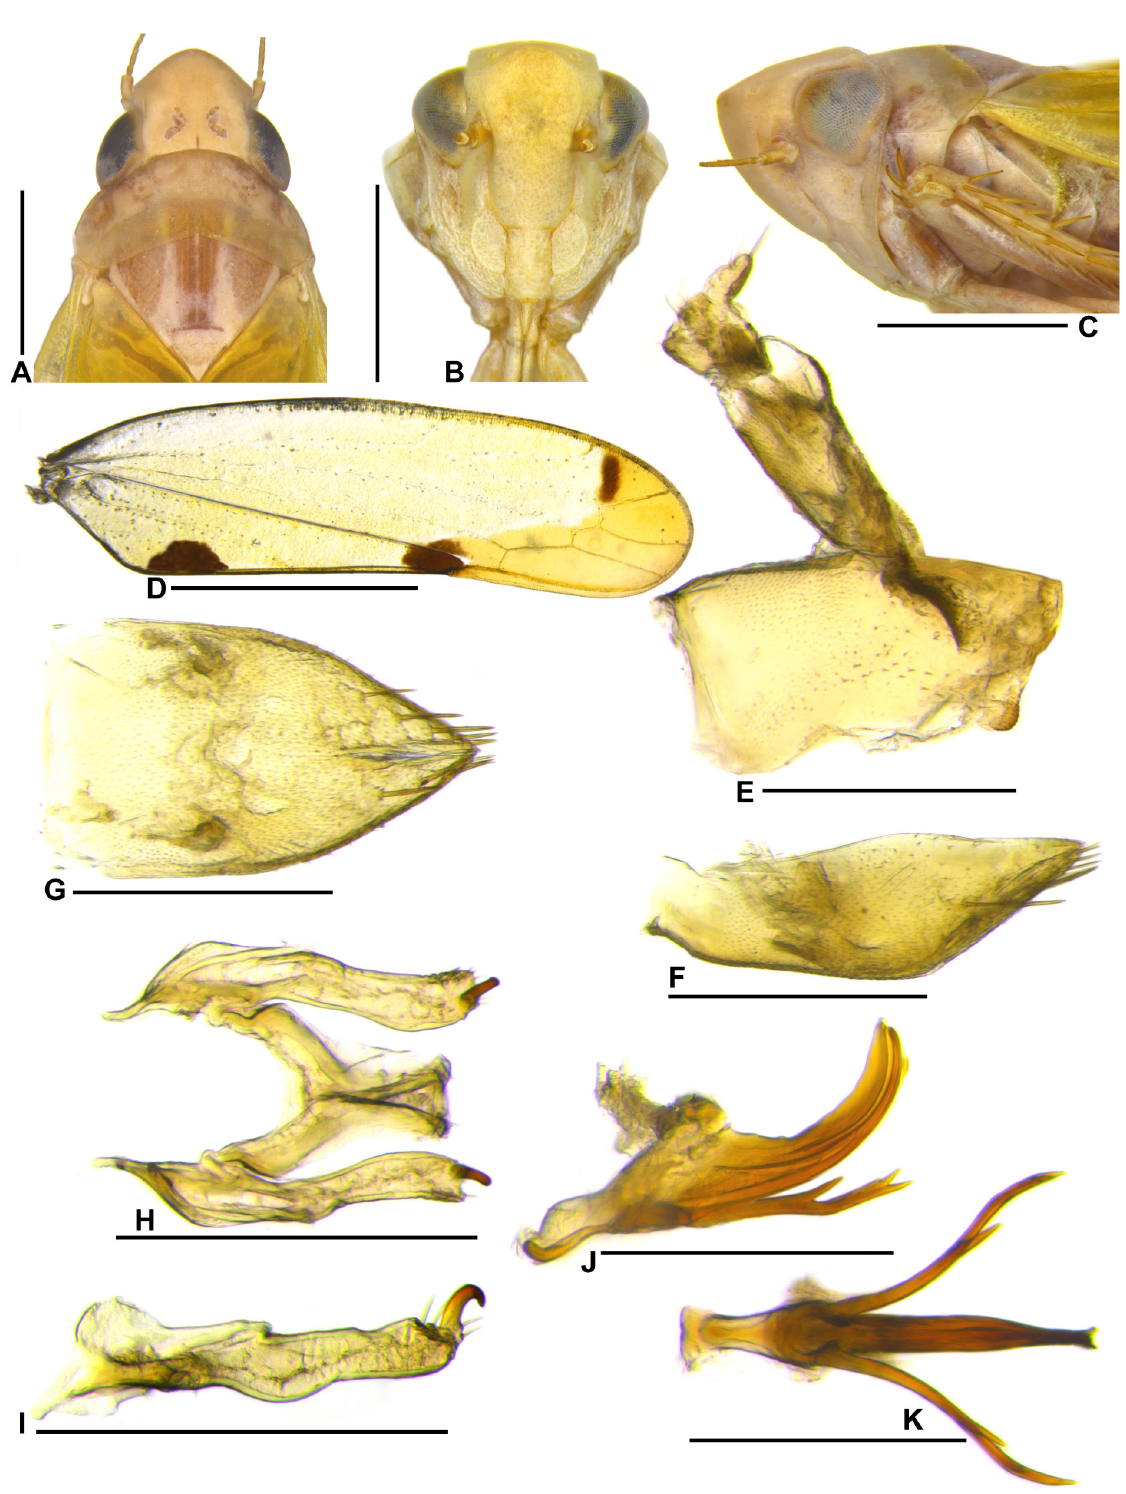
Fig. 1. Takiyaella anomala gen. et sp. nov., ♂, holotype (DZRJ-AUCH #238). A . Head and thorax, dorsal view. B . Head, frontal view. C . Head and thorax, lateral view. D . Forewing. E . Pygofer and anal tube, lateral view. F . Valve and subgenital plate, lateral view. G . Valve and subgenital plate, ventral view. H . Styles and connective, dorsal view. I . Style, lateral view. J . Aedeagus, lateral view. K . Aedeagus, ventral view. Scale bars: A–C = 1.0 mm; D = 2.0 mm; E–I = 0.5 mm; J–K = 0.4